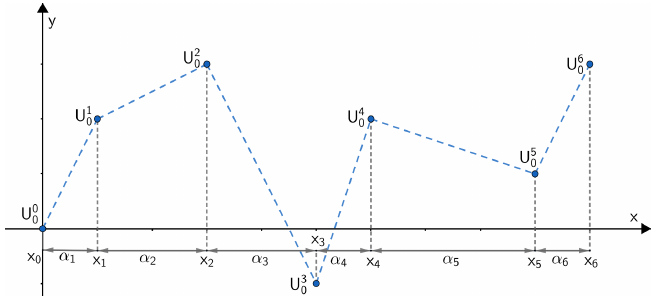
) , i = 1, . . . , N are defined by the discrete function U Figure 2. Points ( x i , U i 0 C 0 is shown by the blue dashed line.